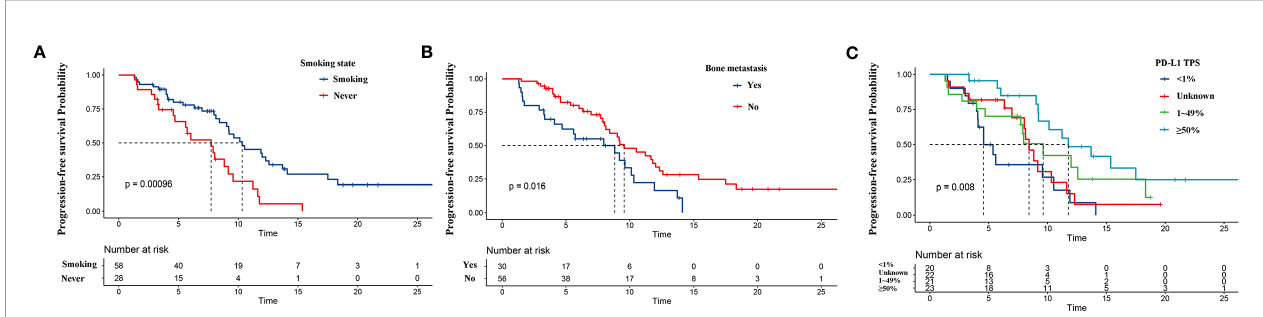
FIGURE 2 | Kaplan – Meier curves for progression-free survival (PFS) based on predictors from the nomogram. PFS according to (A) smoking, (B) bone metastasis status, and (C) programmed cell death ligand-1 (PD-L1)